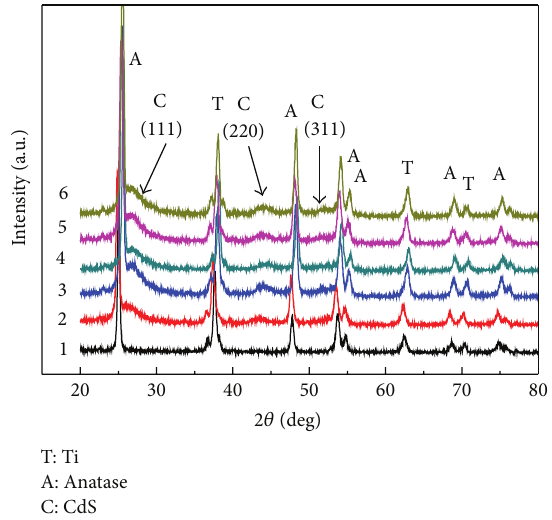
Figure 4: XRD patterns of CdS/TNAs without modification (curve 2) and modified with TiCl 4 (curve 3), HNO 3 (curve 4), KOH (curve 5), and MTMS (curve 6), respectively. Curve 1 refers to the XRD pattern of the reference TNAs